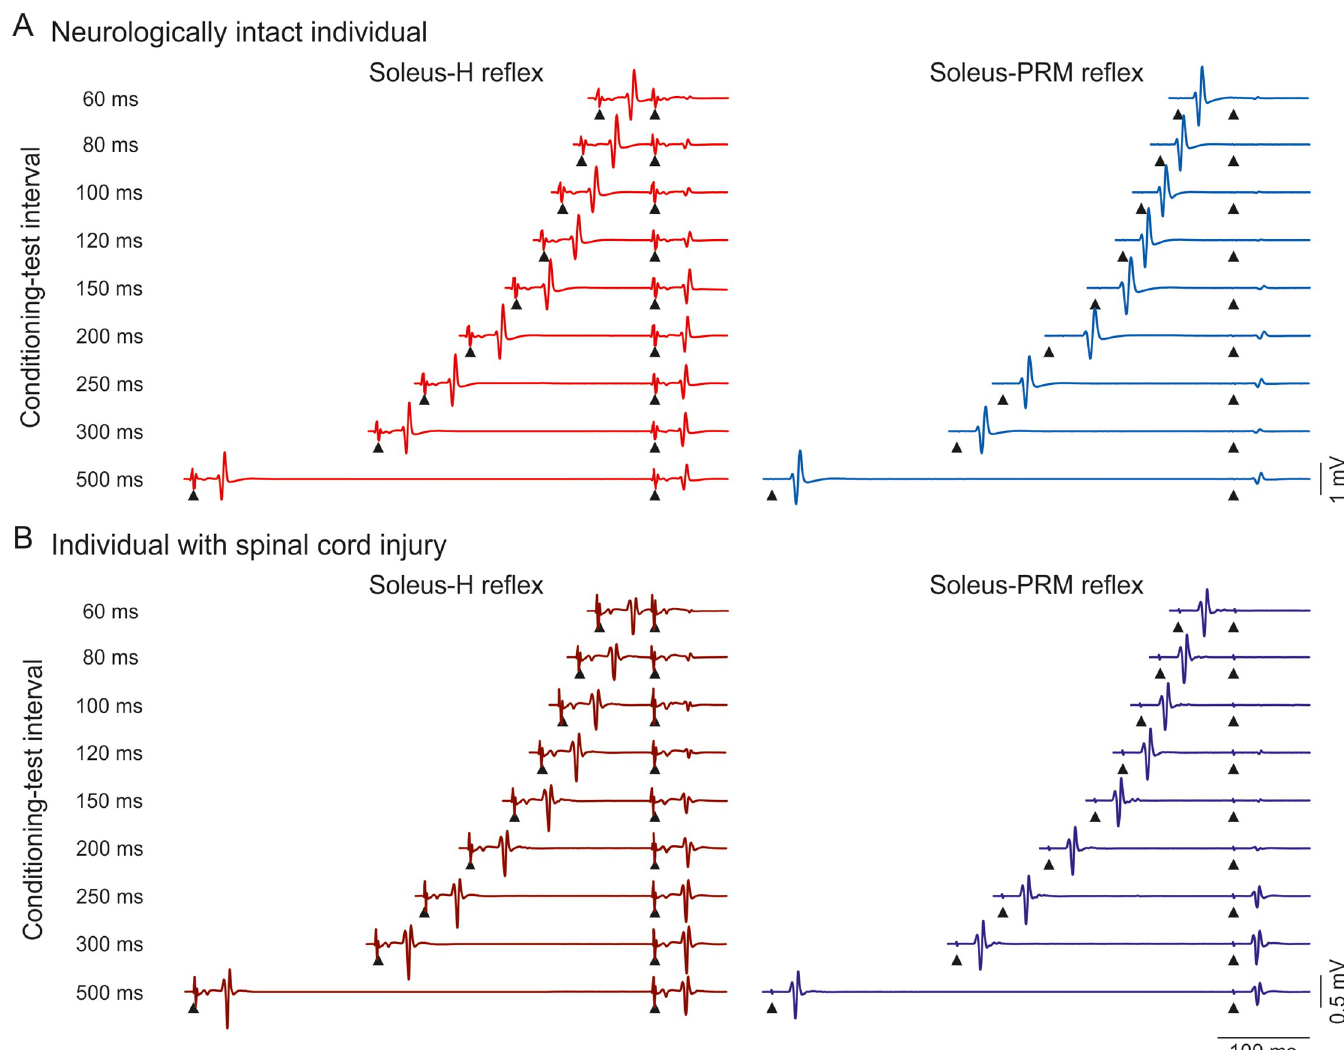
Fig 1. Exemplary H reflexes and PRM reflexes of soleus tested by paired-pulse paradigm. H reflexes (red EMG traces) of the right soleus and PRM reflexes (blue traces) evoked in the same muscle for a sub-set of conditioning-test intervals as indicated, derived from (A) a neurologically intact participant and (B) an individual with spinal cord injury (subject 9). Each trace is the average of ten responses. Black arrowheads mark times of stimulus